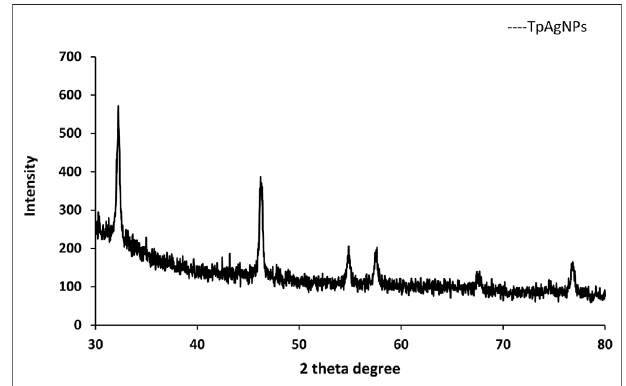
FIGURE4| X-raydiffractionanalysisofbiosynthesizedTpAgNPsfrom T. pallida .